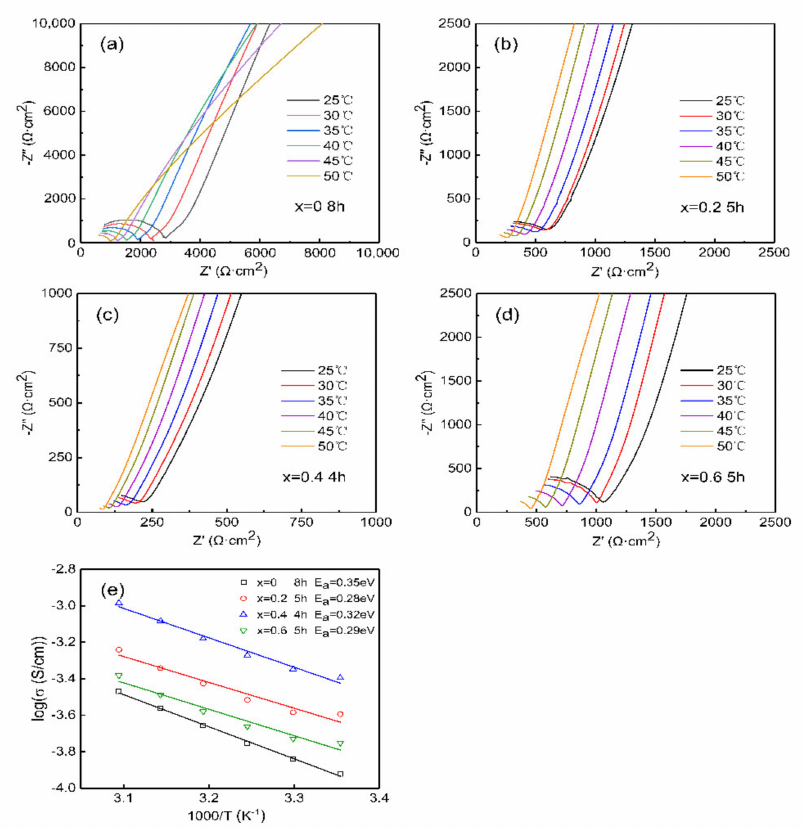
Figure 6. Nyquist plots of LLZN x O (x = 0, 0.2, 0.4, 0.6) ceramics at 25–50 ◦ C: ( a ) x = 0, 8h ( b ) x = 0.2, 5 h, ( c ) x = 0.4, 4 h, ( d ) x = 0.6, 5 h. ( e ) Temperature dependence of conductivity of LLZN x O (x = 0, 0.2, 0.4, 0.6) ceramics. Solid symbols are experimental data, and the lines are fitting curves according to Arrhenius